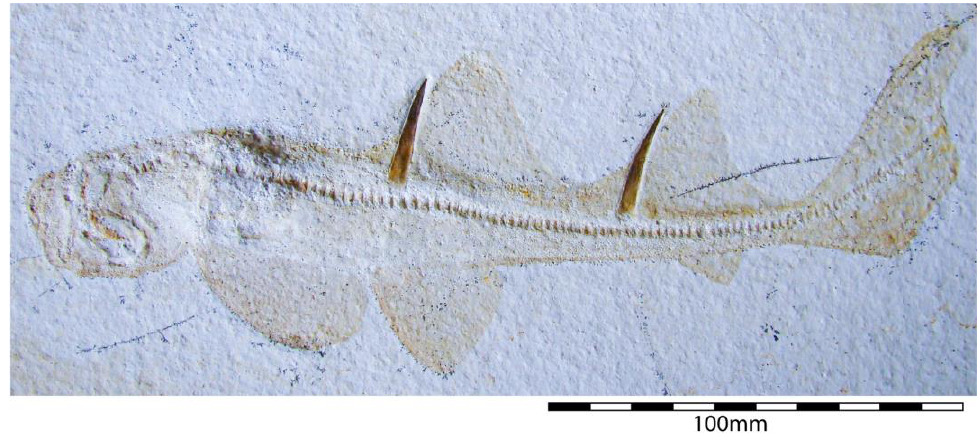
Figure 19. Holotype specimen of † Paracestracion danieli Slater, 2016 [221] (JPBP-SOL-0005) from the Kimmeridgian of Eichstätt.